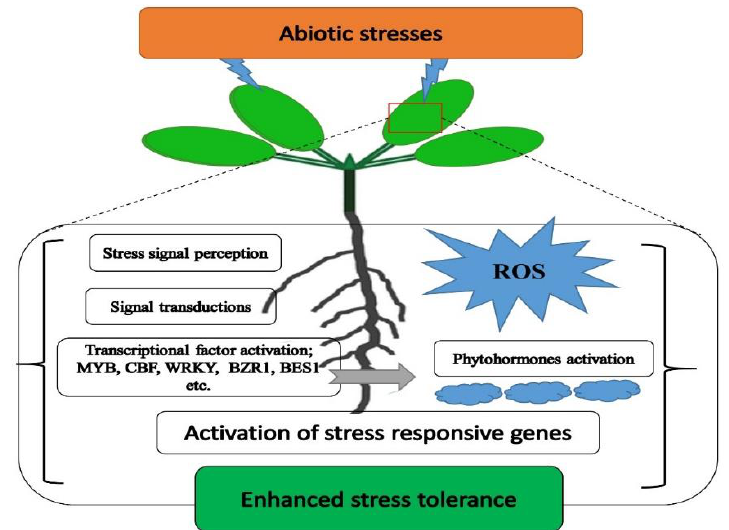
Figure 1. A simplified scheme of mechanism for abiotic stress tolerance in plants. Abiotic stress is involved in the overproduction of reactive oxygen species (ROS), which causes cell death. A complex plant defense system stabilizes the ROS production and protects the plant cells.